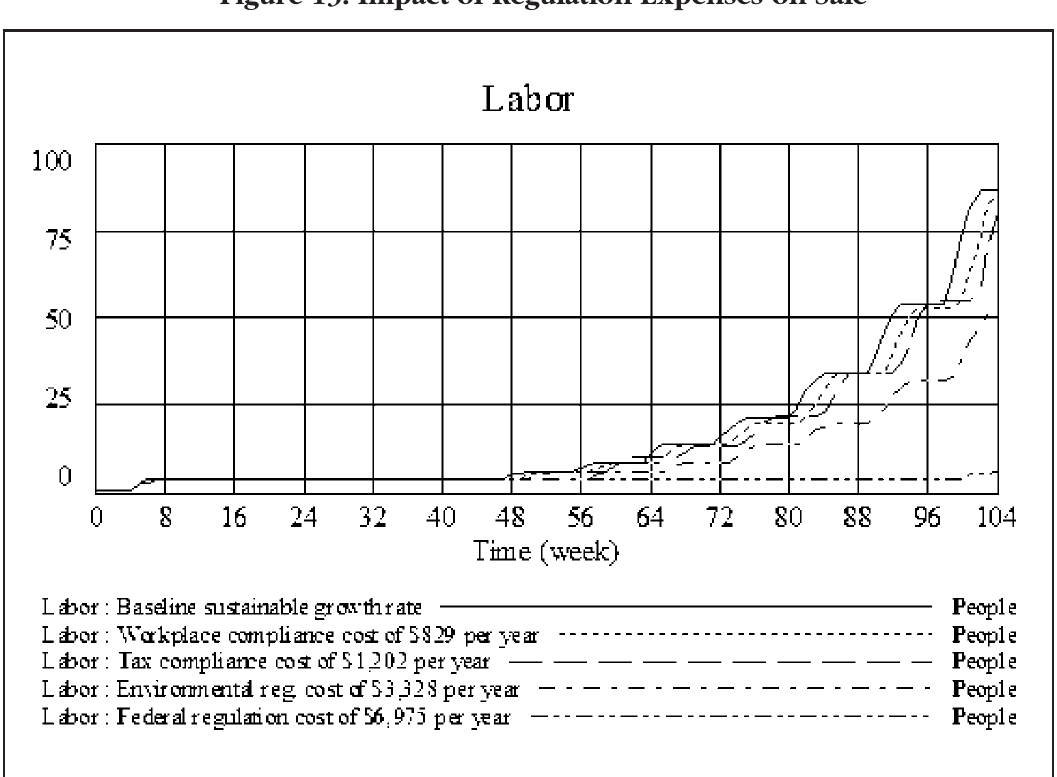
Figure 13. Impact of Regulation Expenses on Sale